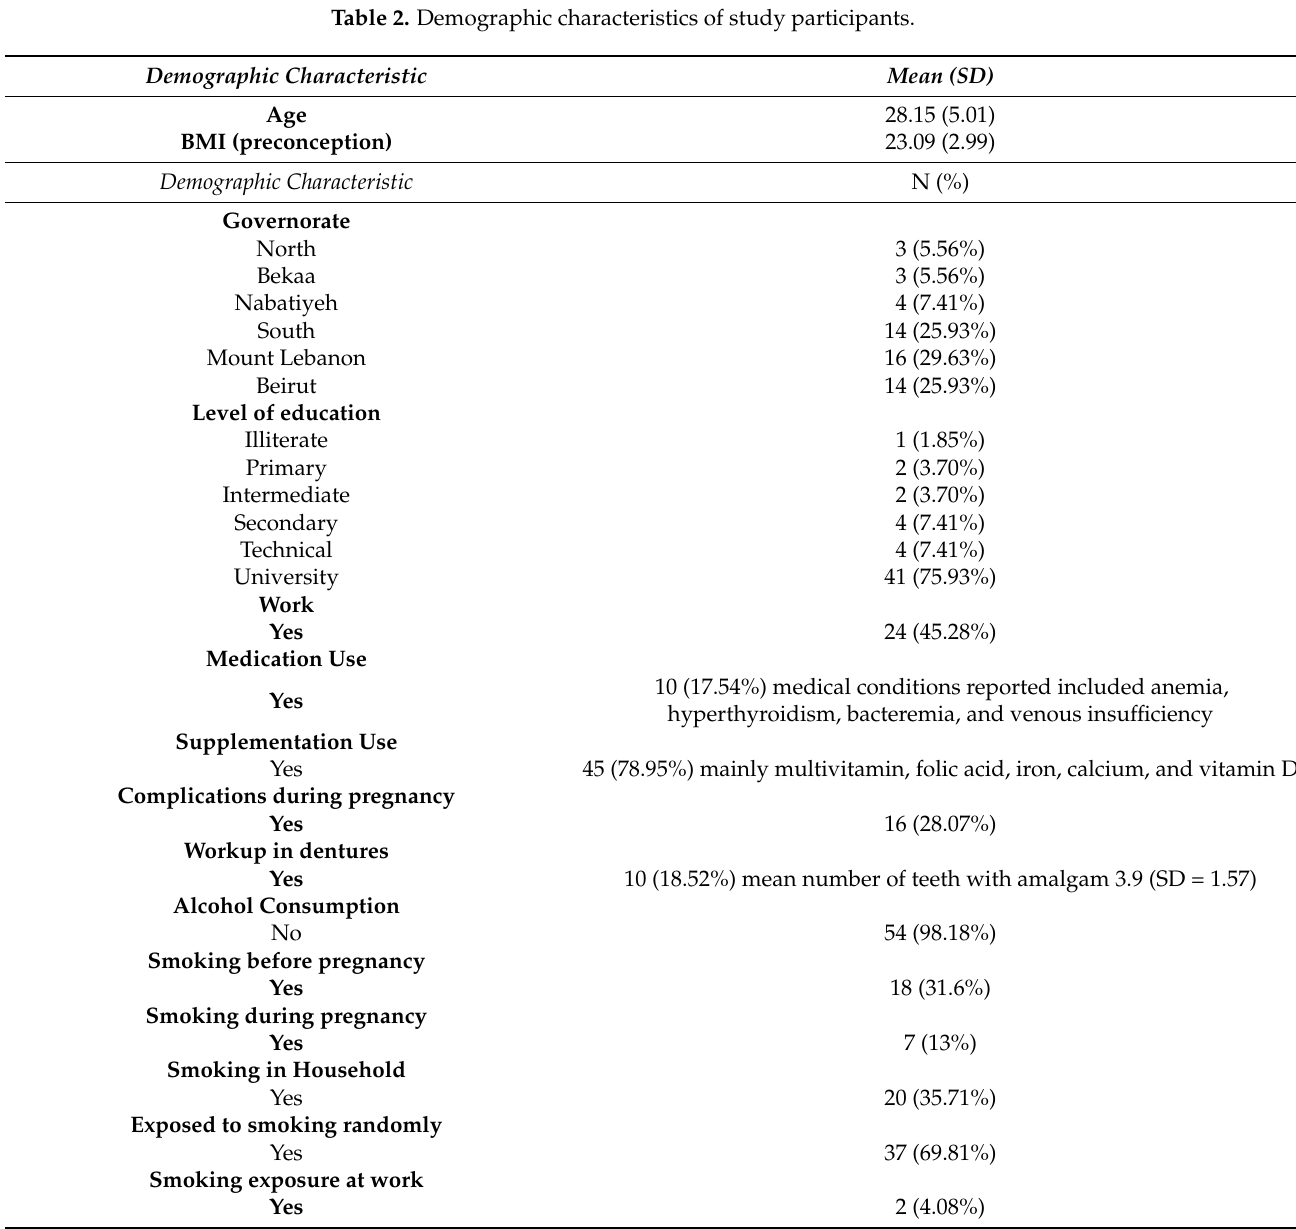
Table 2. Demographic characteristics of study